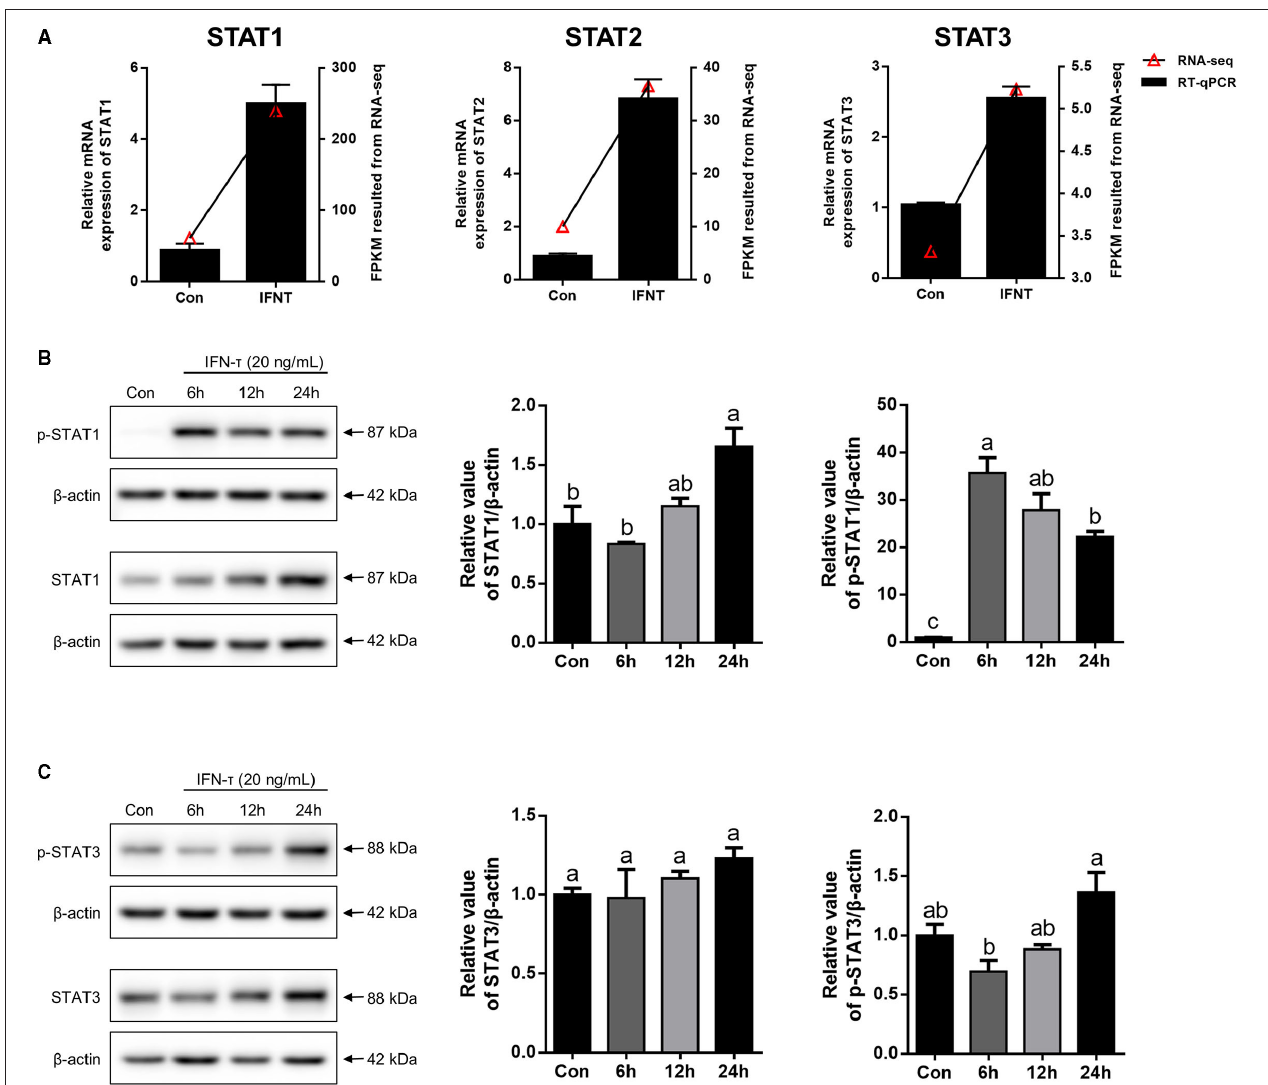
FIGURE 4 | The expression analysis of STATs in IFNT-treated gEECs. (A) To validate RNA-seq data, the mRNA level of STAT1, STAT2, and STAT3, which was detected by qRT-PCR after gEECs were treated with 20ng/mL IFNT for 6h. Gene expression was normalized to GAPDH. Values represent as the mean ± S.E.M. from three independent experiments, and compared with the control group. ( B,C) The protein expression of STAT1, p-STAT1, STAT3, and p-STAT3 was analyzed using Western Blotting after 20ng/mL IFNT treatment for 6, 12, and 24h. The data are presented as the mean ± S.E.M. from three independent experiments, and bars with different letters (a/b/c) are significantly different ( p <